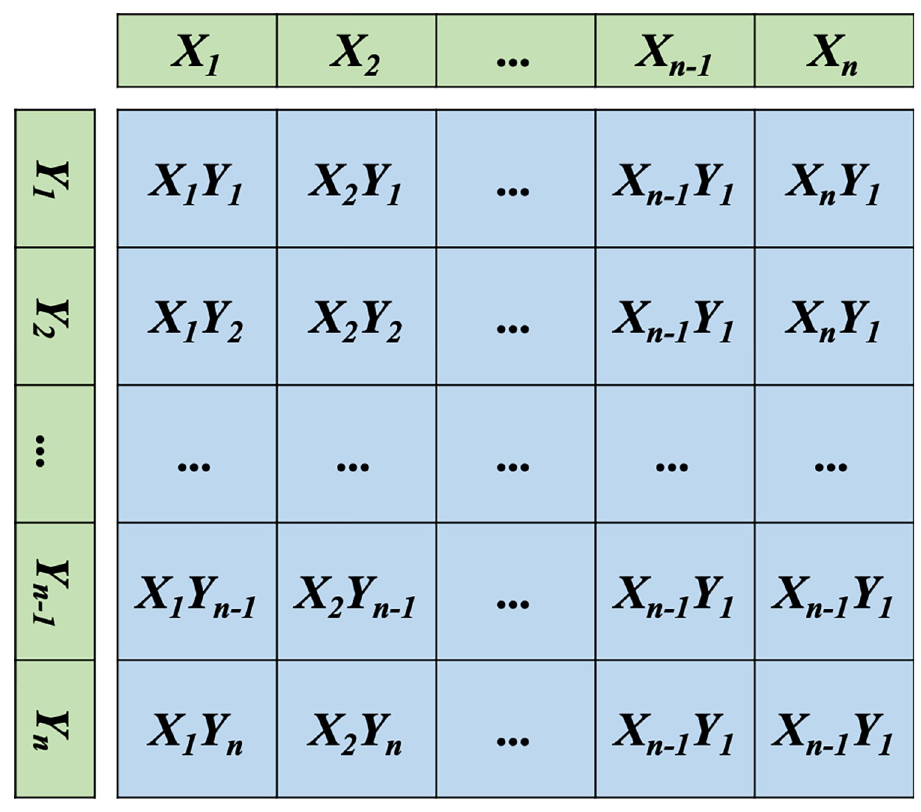
Fig 2. The generation of accessible chromatin